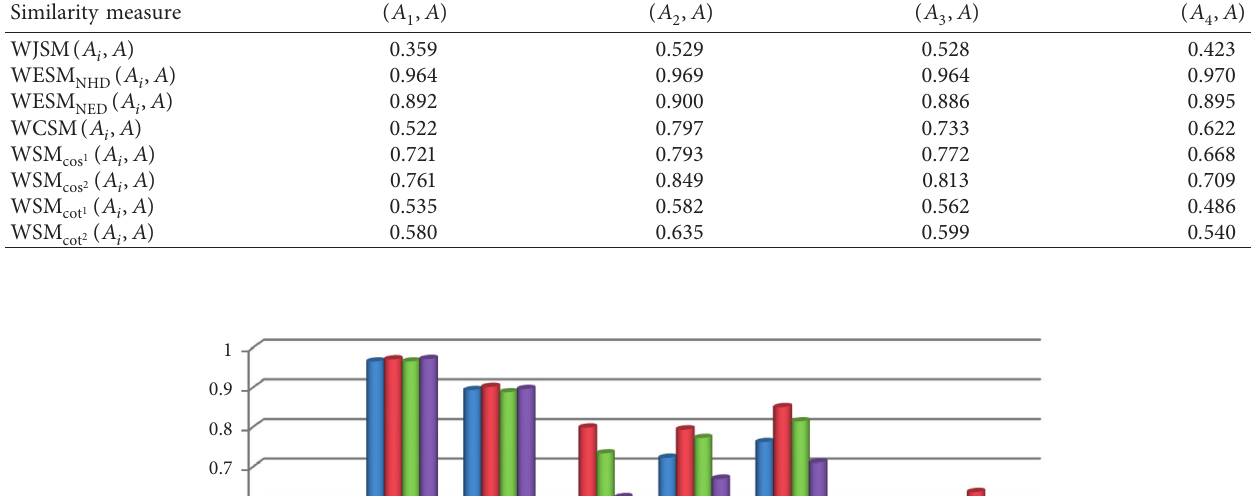
Table 3: The weighted similarity measures between A